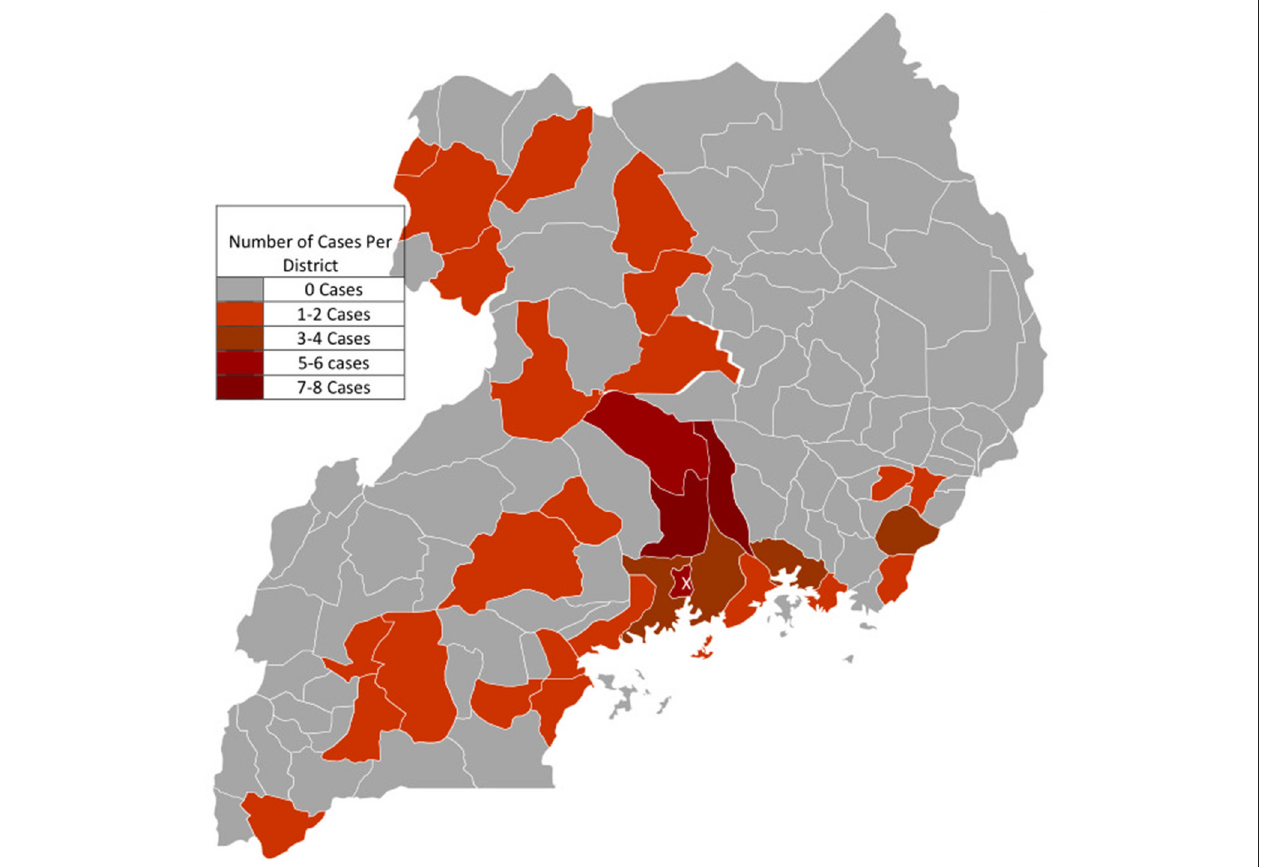
FIGURE 3 | Geographic Origin of Cases with Endomyocardial fibrosis. X: The capital City Kampala where The Uganda Heart Institute is located in the Mulago National Specialized Hospital Complex. Cases were mostly clustered around districts bordering Kampala, especially to the East and North of Kampala.